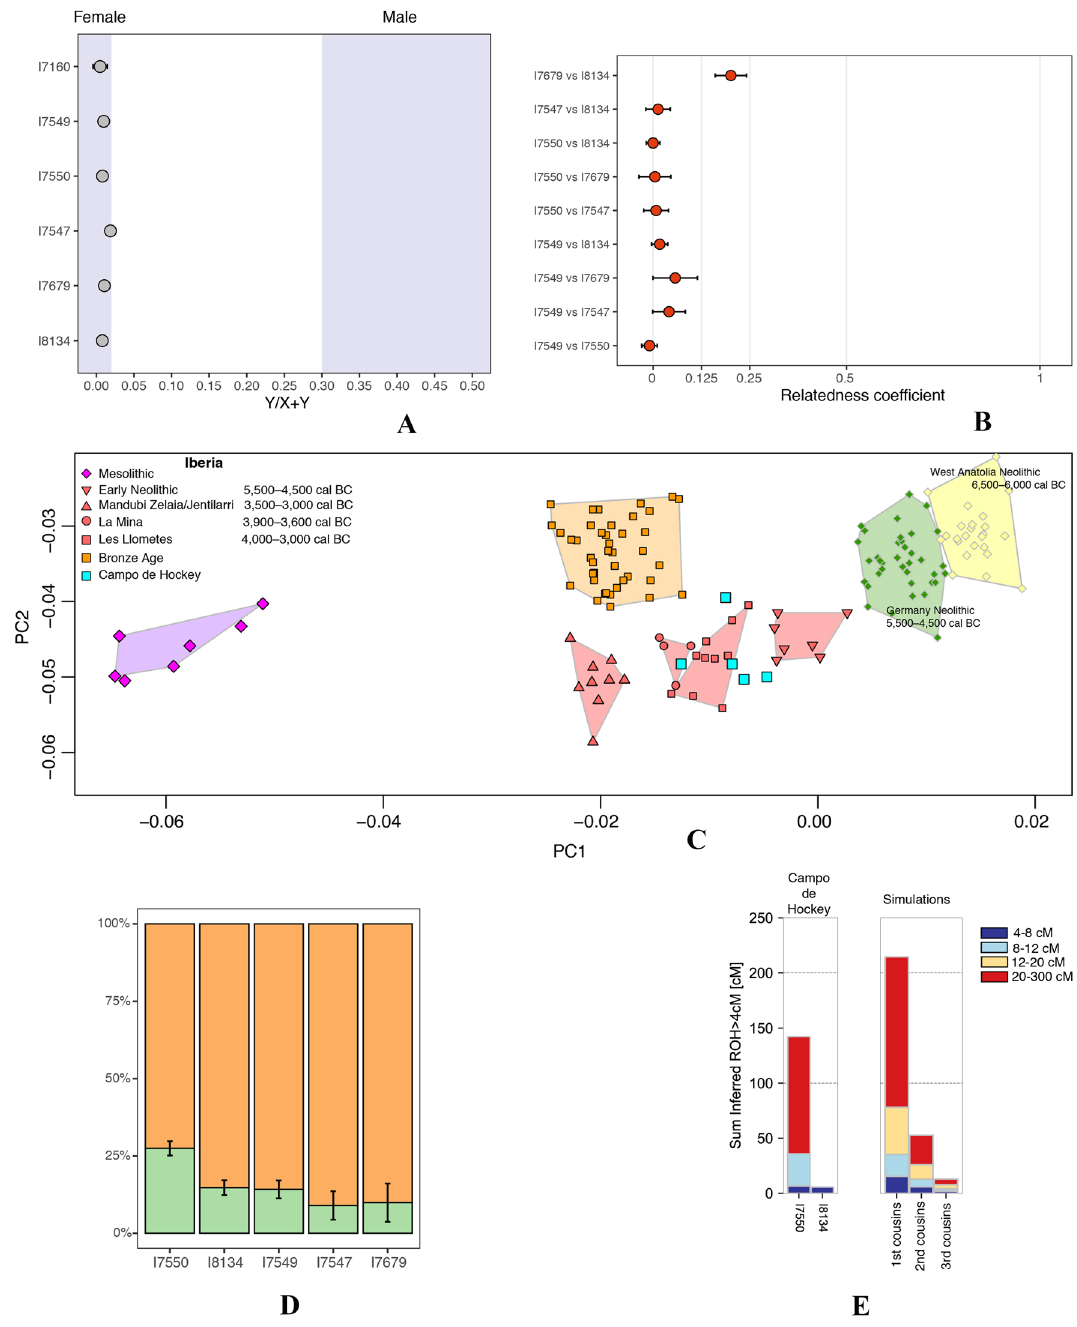
Figure 8. ( A ) Genetic sex determination using the ratio of the number of DNA sequences mapping to the Y-chromosome and the total number of sequences mapping to sex chromosomes 37 . Bars represent 95% confidence intervals. ( B ) Relatedness coefficients computed on the autosomal chromosomes as in 36 for all the pairwise comparisons between Campo de Hockey individuals. Bars represent 95% confidence intervals. ( C ) Principal Components Analysis of Campo de Hockey individuals and other ancient individuals from Iberia and other European populations. Using smartpca in Eigensoft software 40 , ancient individuals were projected onto the principal components computed on a set of present-day West Eurasians (not shown in the figure) genotyped on the Human Origins Array. ( D ) Ancestry proportions deriving from Iberian Early Neolithic populations (orange) and from European Mesolithic hunter-gatherers (light green), computed with qpAdm. Bars represent ±1 standard error. ( E ) Runs of homozygosity length distribution computed with hapROH 45